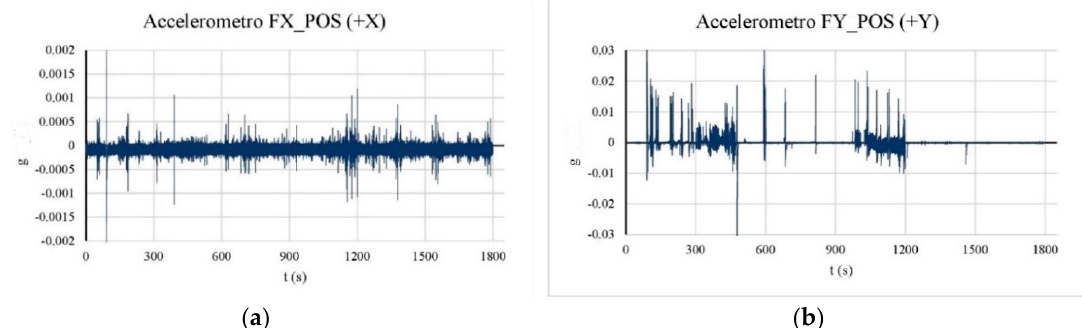
Figure 11. ( a ) Accelerometers in position A; ( b ) accelerometers in position E; ( c ) accelerometers in position M.